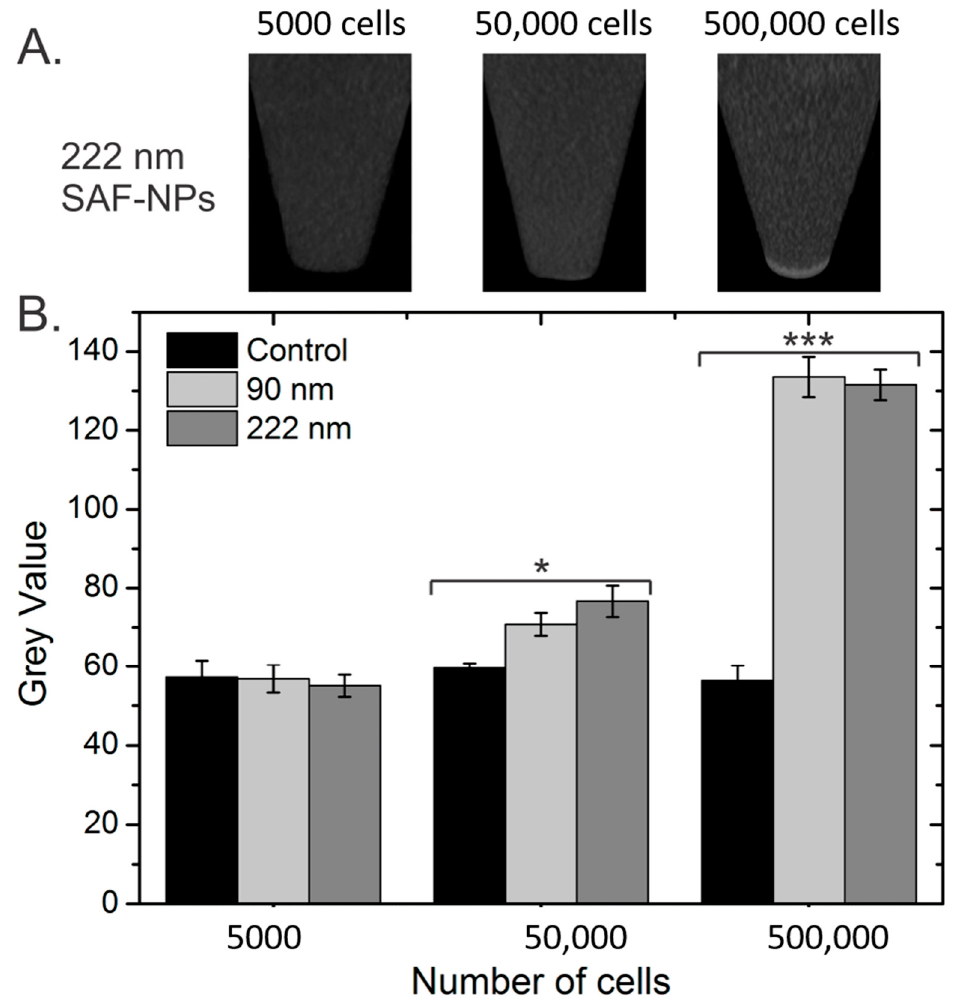
Figure 3. In vitro CT images of the SAF-NP labeled SKOV 3 cells in an agar phantom. ( A ) CT scans of the pelleted SAF-NP-labeled SKOV3 cells for the given cell number and SAF-NP size. ( B ) Grey value for the control (unlabeled), 90 nm SAF-NP and 222 nm SAF-NP samples as a function of the number of cells. * p < 0.05, *** p < 0.001.